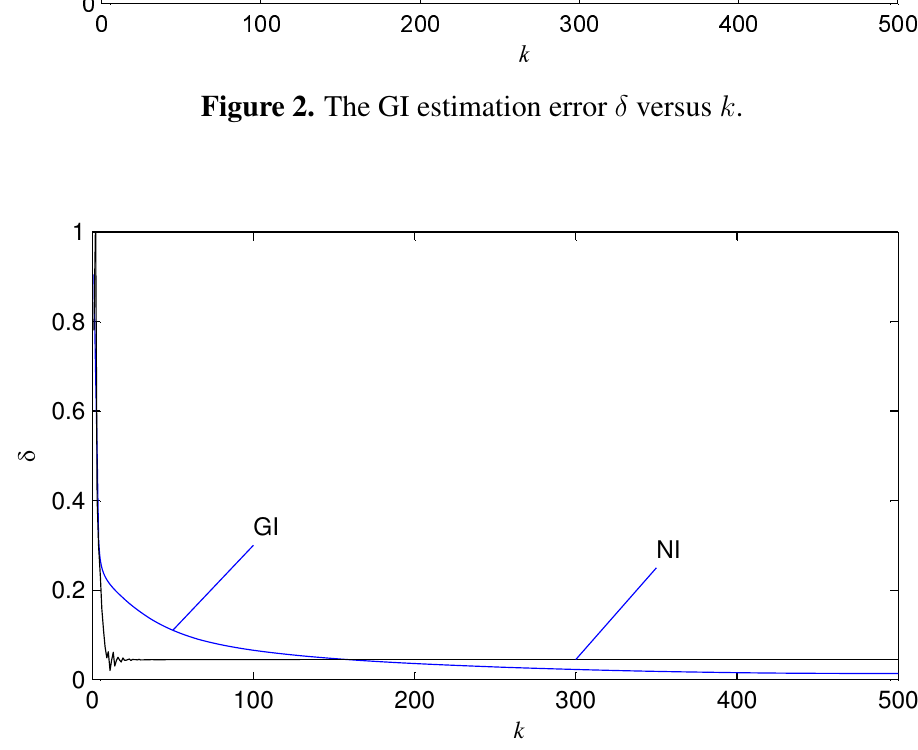
Figure 3. The GI and NI estimation error δ versus k ( σ 2 = 0 . 20 2